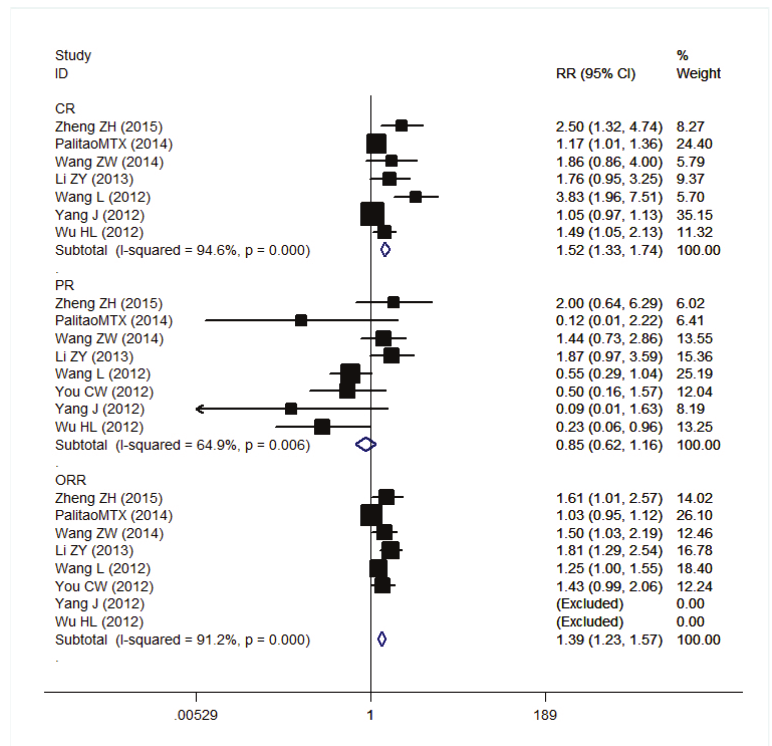
Figure 3: Forrest for clinical efficacy of S-1 combined with radiotherapy versus radiotherapy alone